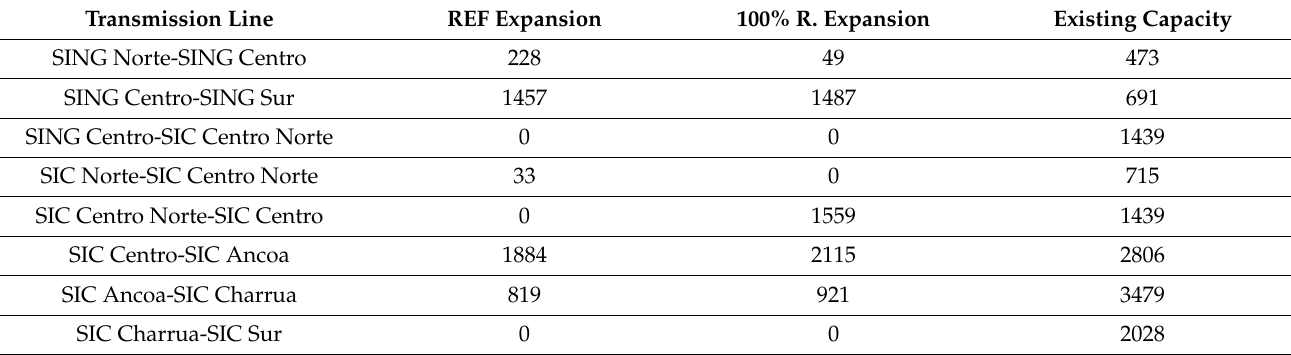
Figure 3. Evolution of installed capacities and generation for the reference scenario. Table 3. Comparison of investment in transmission lines, in MW, for the reference scenario and 100% renewable scenario. The last column shows existing